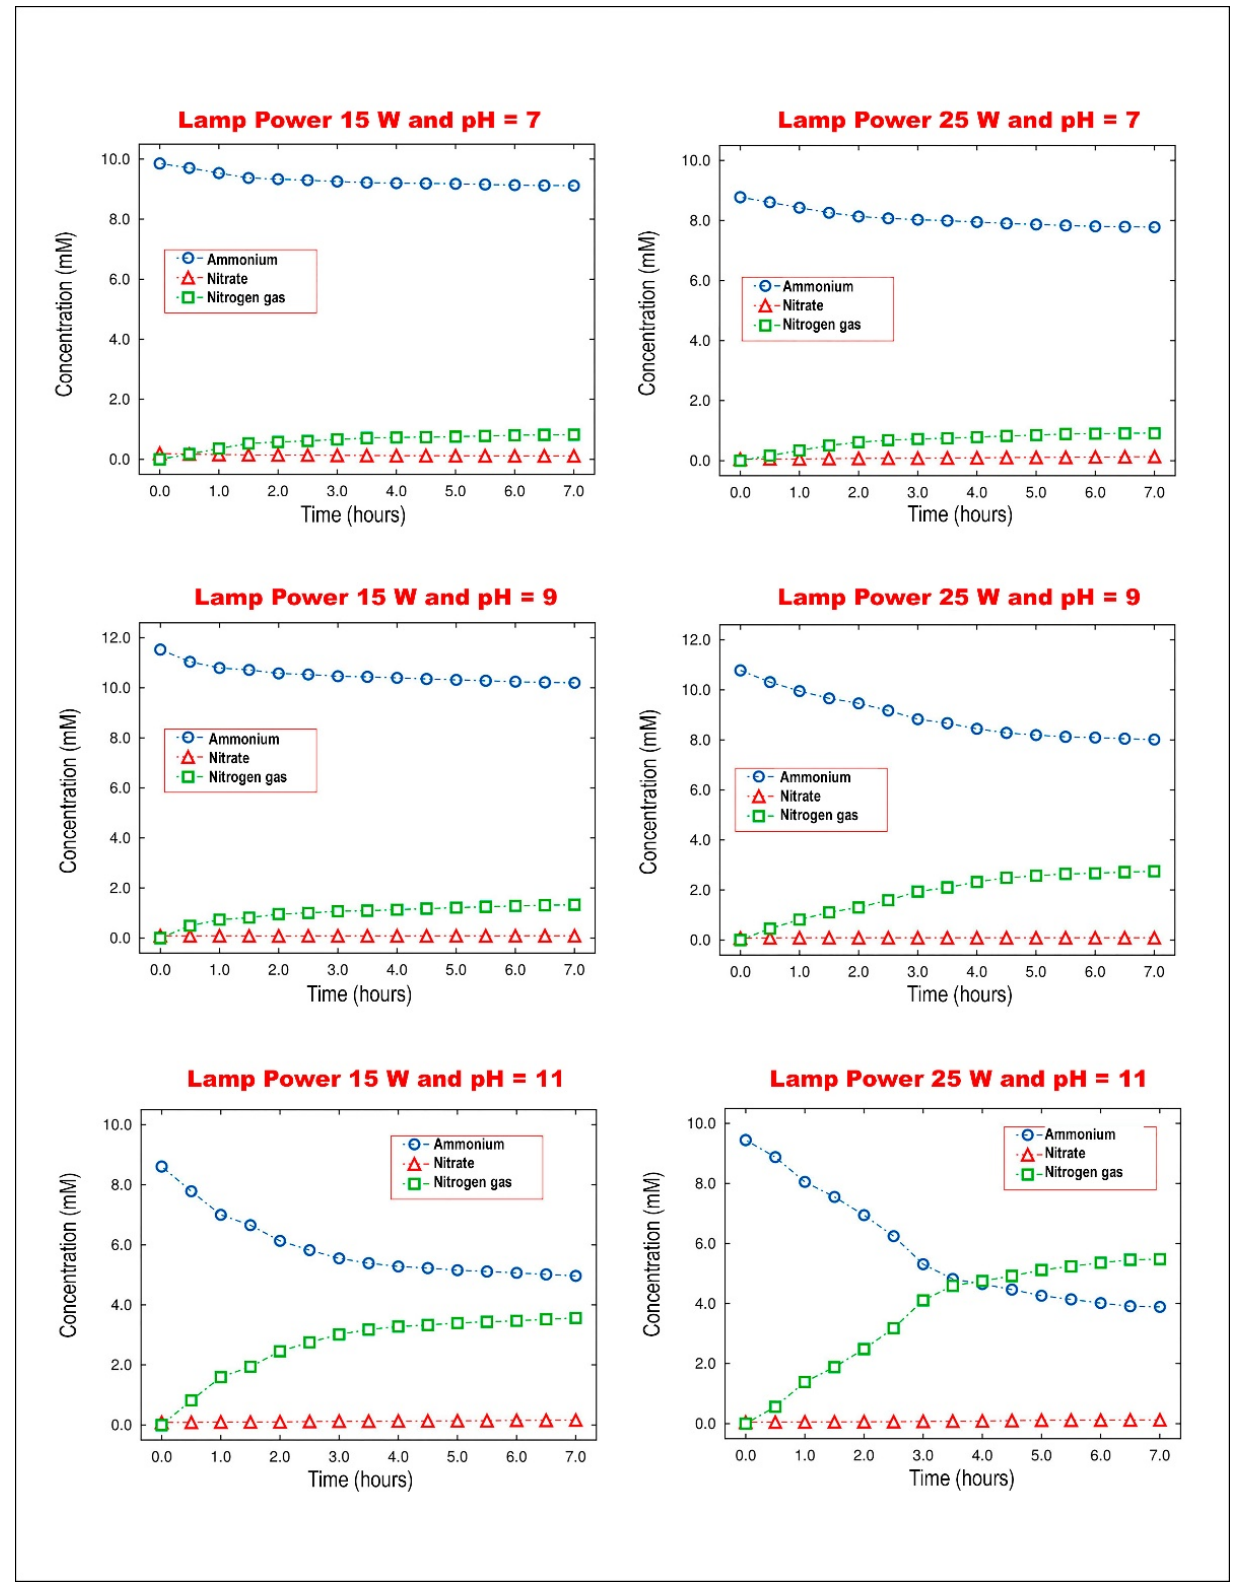
Figure 1. Influence of pH (pH 7.0–11.0) and lamp irradiation power (15 W, 25 W) on the performance and kinetics of NH 4+ /NH 3 removal by photocatalysis. Q = 1000 L/h, temperature 20 ± 1 °C .